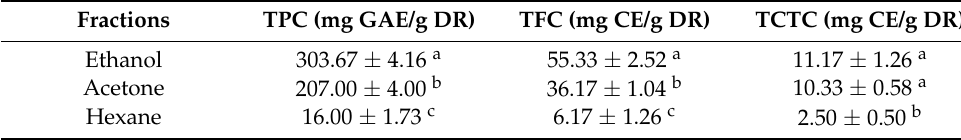
Table 1. TPC, TFC and TCTC of A. indicum shoot extracts.